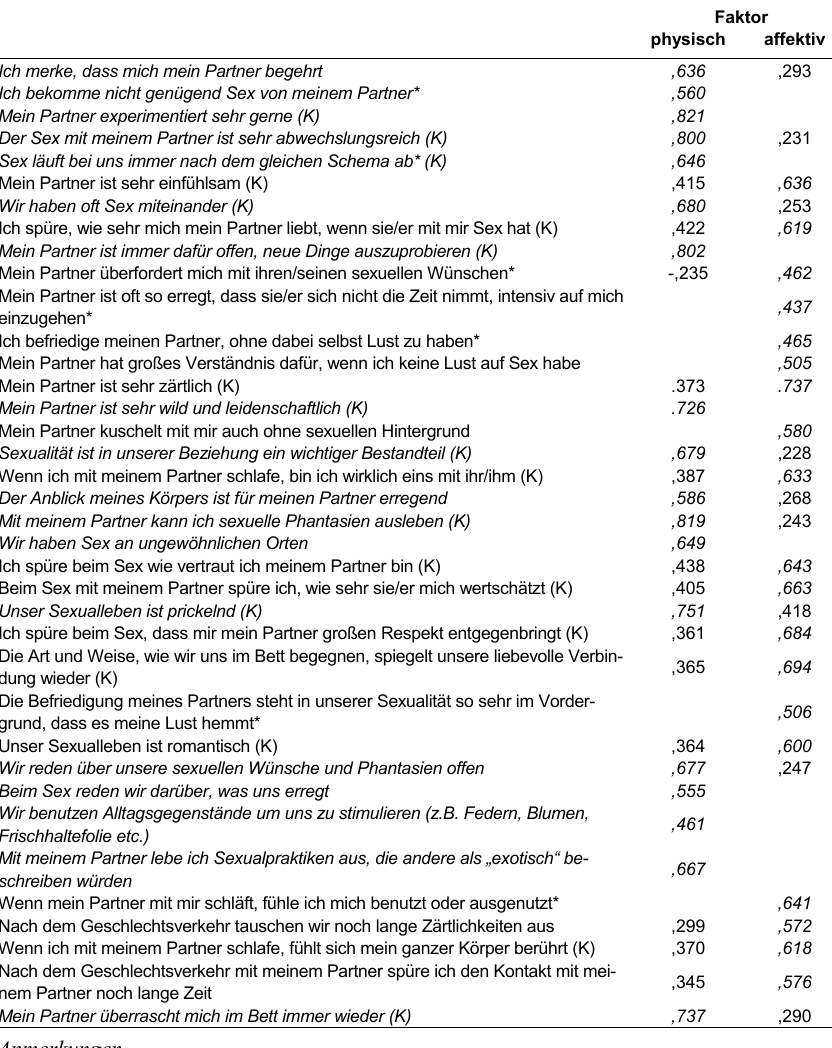
Tabelle 1: Faktorladungen des Fragebogens zum Erleben von Sexualität in einer Partnerschaft